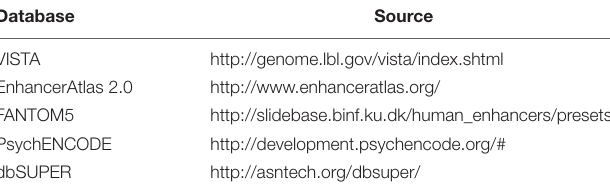
TABLE 2 | Enhancer